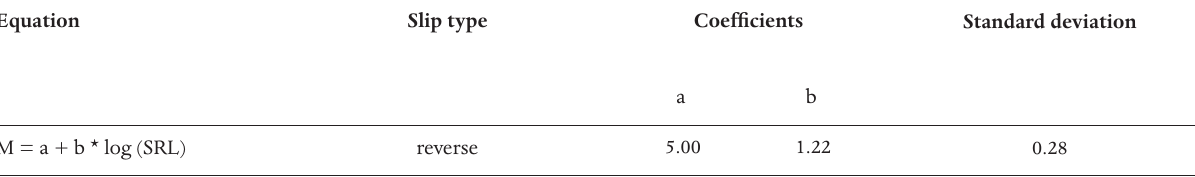
Table 2. Regressions of surface rupture length (SRL in km) and moment magnitude (M) [Wells and Coppersmith 1994].